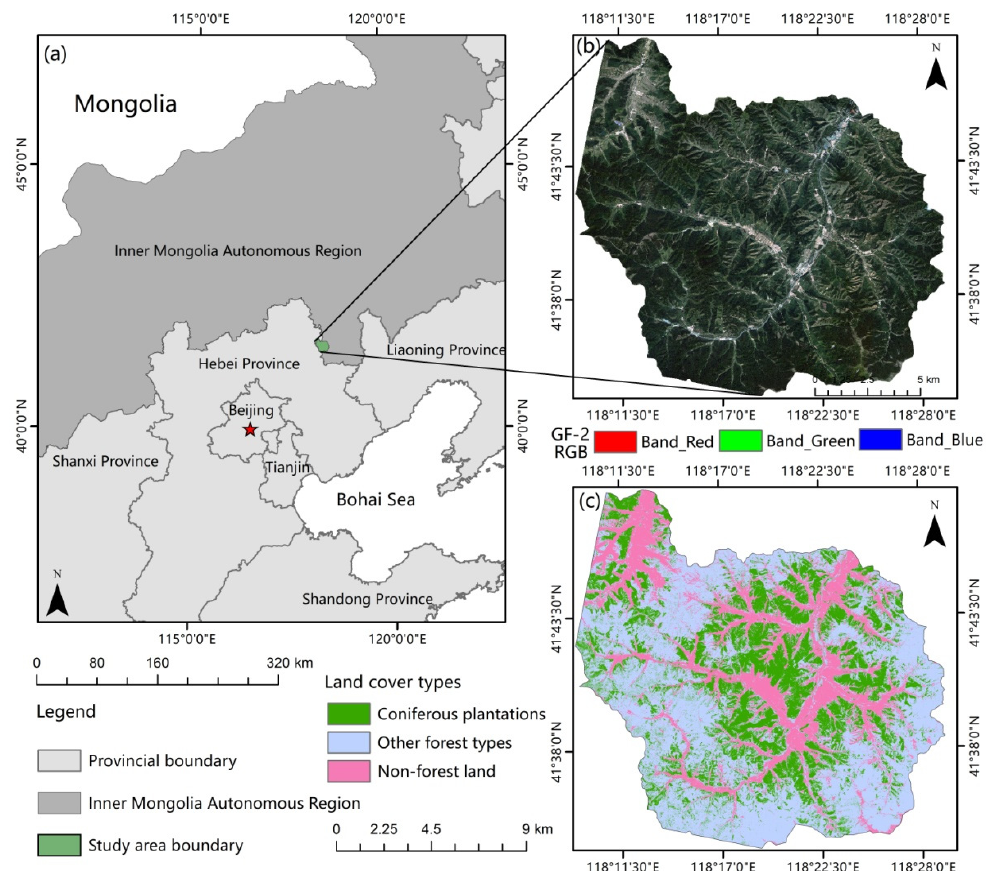
Figure 1. ( a ) Study area location; ( b ) GF-2 images of the study area; ( c ) distribution of coniferous forest, other forest types, and non-forest land in the study